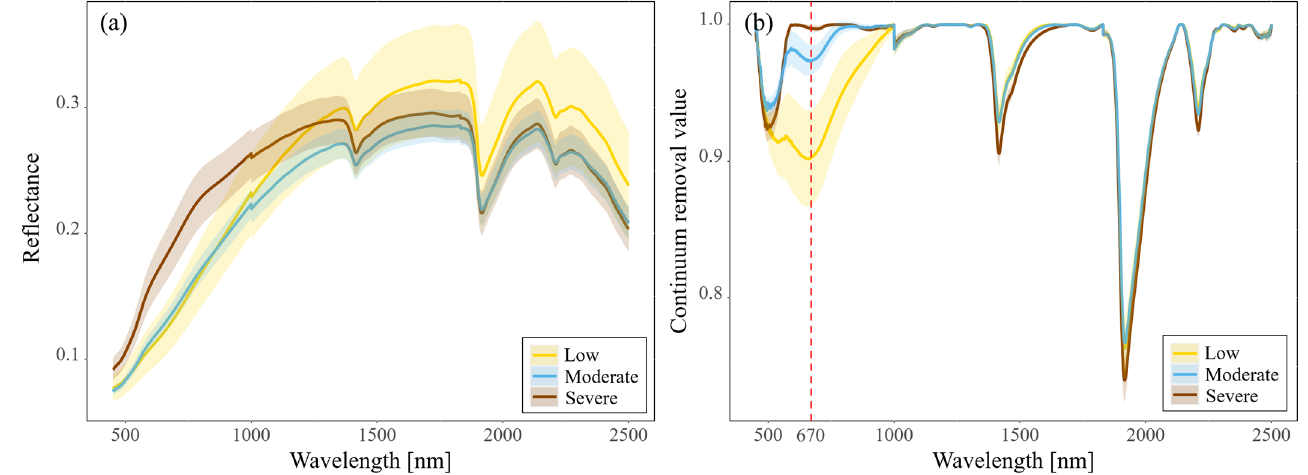
Figure 4. Laboratory-based mean spectra of topsoil in three soil erosion intensity classes. ( a ) Raw spectra and ( b ) continuum-removed reflectance. Shaded areas represent standard deviations from the mean.